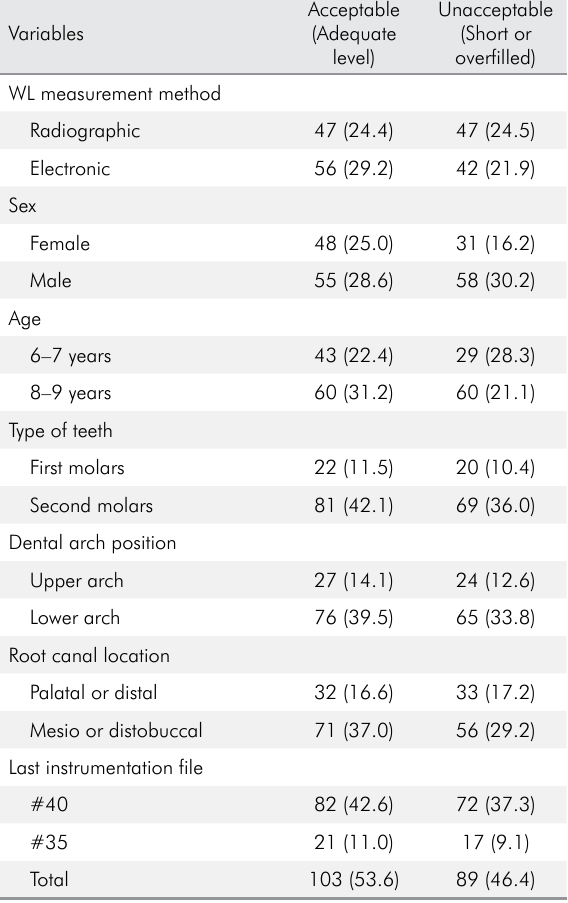
Table 1. Sample distribution according to the obturation level (n = 192).